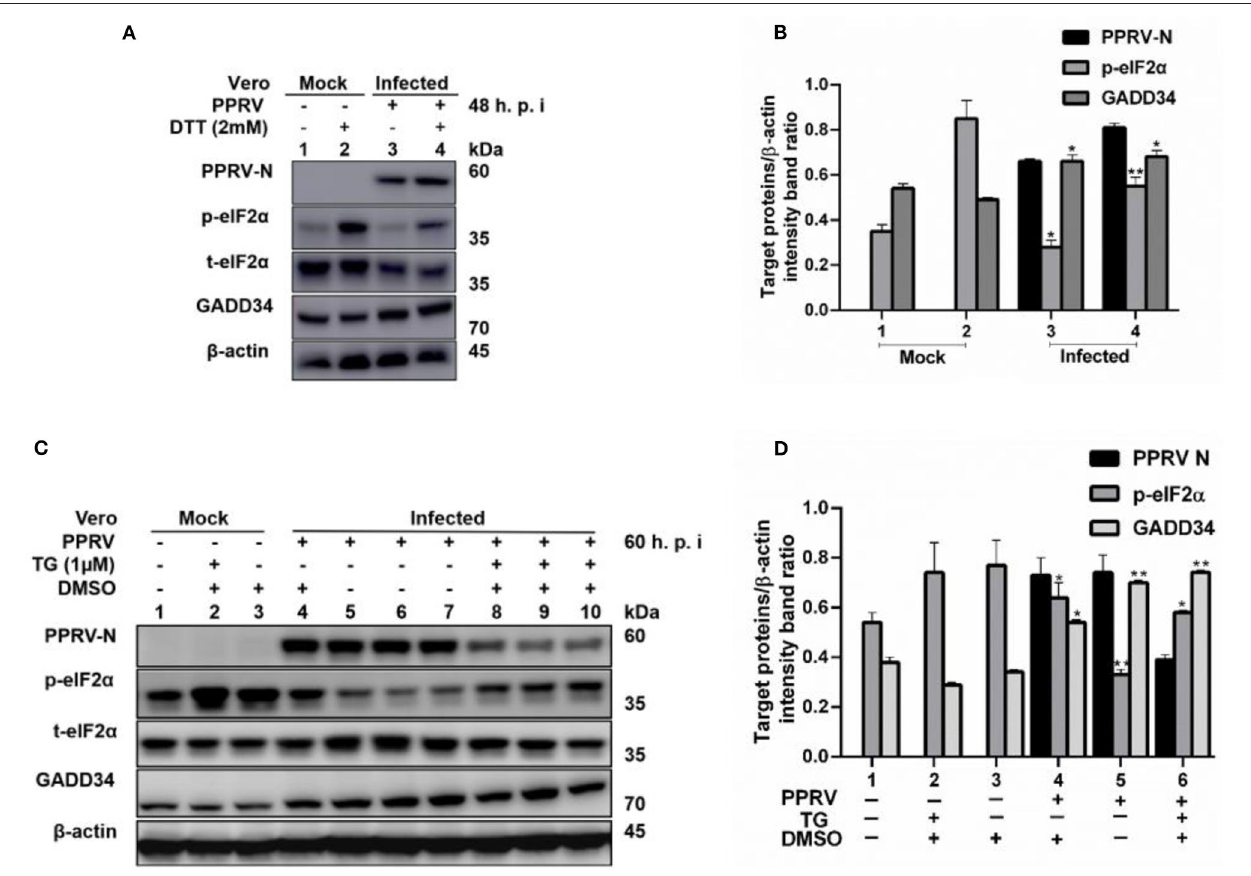
FIGURE 3 | PPRV infection represses ER stress-induced eIF2 α phosphorylation in Vero cells. Vero cells were infected with PPRV or mock-infected. (A,C) PPRV infection represses eIF2 α phosphorylation, induced by DTT and TG, respectively. PPRV-infected or mock-infected cells were treated with DTT (2mM) or TG (1 µ M) for 2h (for DTT) or 12h (for TG), respectively, to induce ER stress. The effect of PPRV on p-eIF2 α and GADD34 expression in DTT- or TG-treated groups were analyzed by Western blot. (B,D) Densitometry quantification of p-eIF2 α and GADD34 was normalized to β -actin. Fold change was measured and compared with mock-infected treated or untreated by ImageJ analysis. Statistical analysis was performed using GraphPad Prism 8.0 software. Shown are representative immunoblots with the error bars representing the mean ± SD from three independent experiments. Asterisks represent statistically significant differences between treated and untreated groups (* P < 0.05; ** P < 0.01). # In the graphic (D) , plot 5 represents one set of untreated samples (lines 5 to 7) and plot 6 represents one set of TG-treated samples (lines 8 to 10).